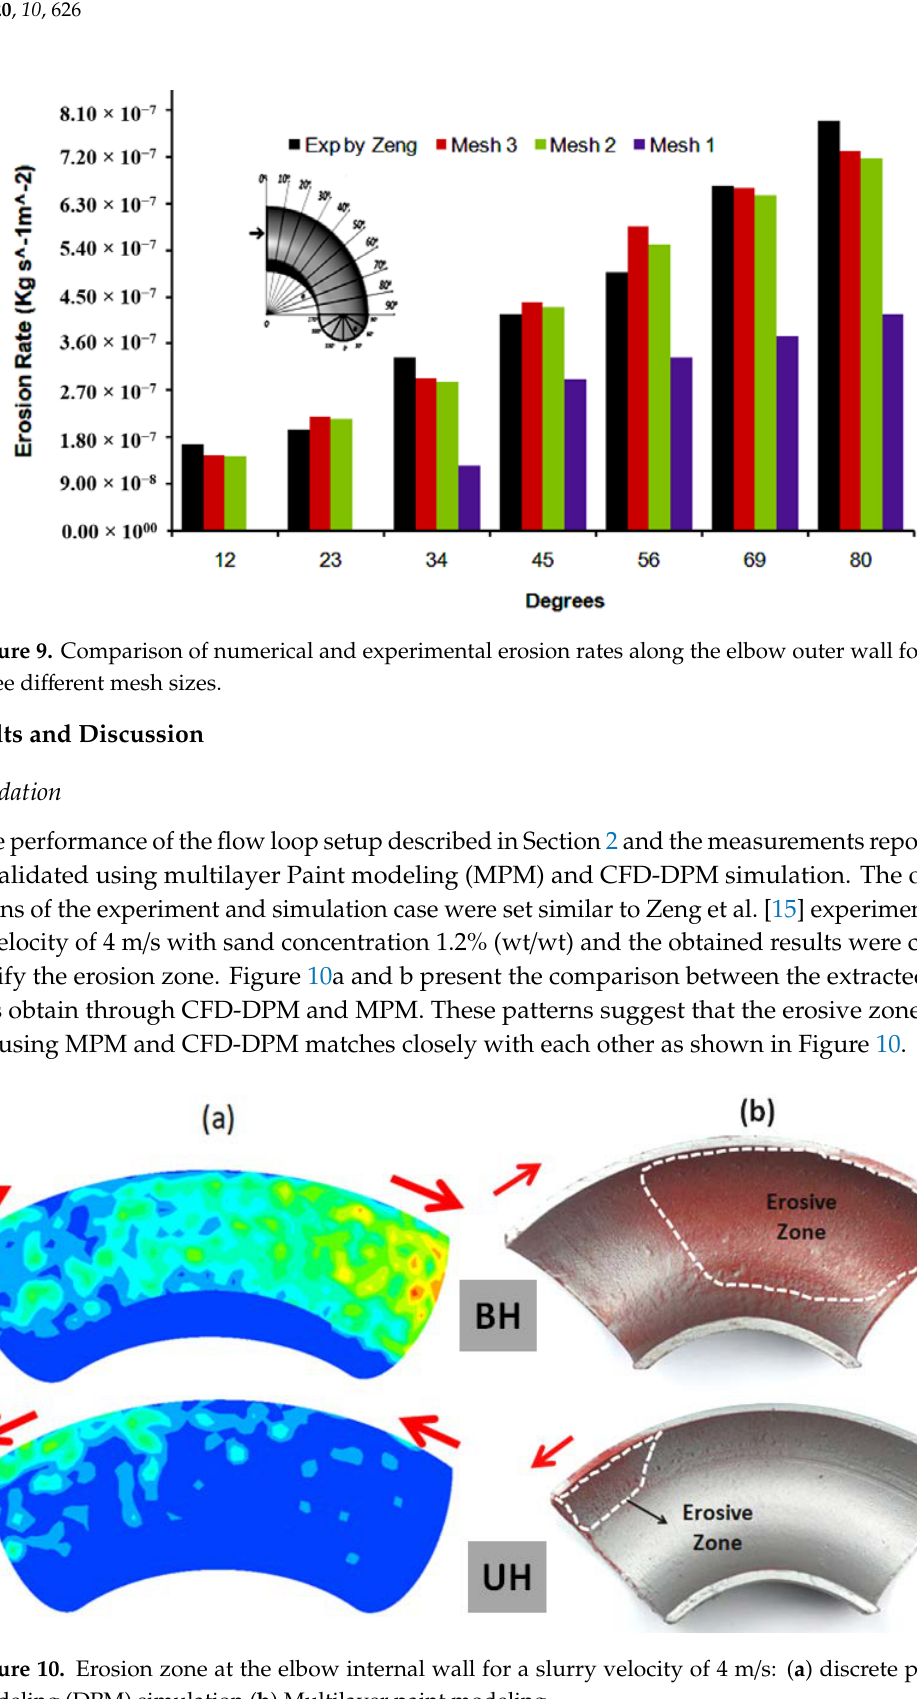
modeling (DPM) simulation ( b ) Multilayer paint modeling.